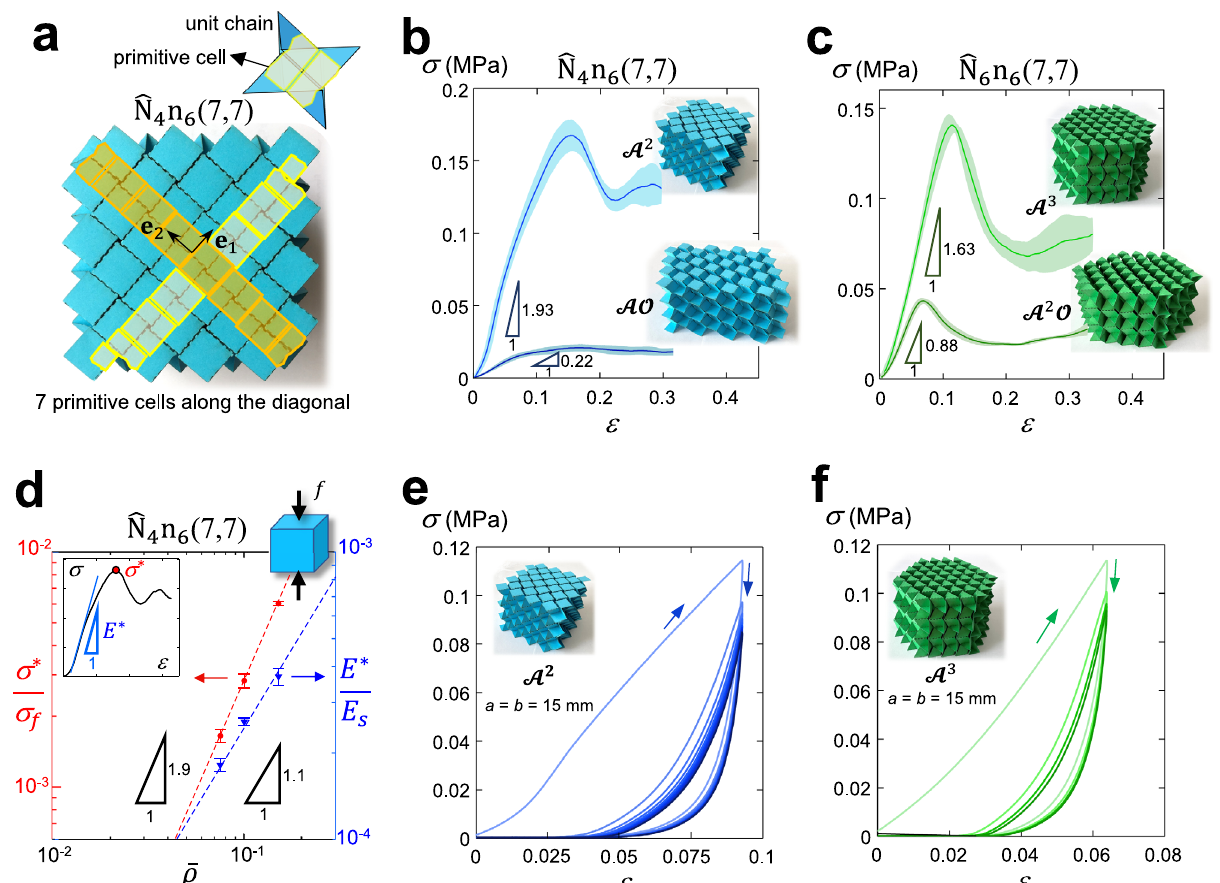
Fig. 5 Out-of-plane compression response of cellular origami-inspired metamaterials. Fabricated samples and measured properties of ^ N 4 n 6 ð 7 ; 7 Þ and ^ N ð 7 ; 7 Þ unit in dissimilar lock modes; a Top view illustration of ^ N 6 n 6 tessellation levels. Engineering stress-strain curves measured for b ^ N 4 n 6 ð 7 ; 7 Þ in two lock con fi gurations A 2 and AO , and for c ^ N 6 n 6 ð 7 ; 7 Þ in two lock con fi gurations A 3 and A 2 O . In b and c the shaded domain describes the dispersion of the results obtained from testing three samples. d Normalized compressive Young ’ s modulus (triangle symbols) and normalized yield strength (circle symbols) of ^ N standard deviation of our measurements. The subset in d schematically illustrates how the compressive Young ’ s modulus E * and yield strength σ * were measured. Cyclic (compressive loading-unloading) response of e ^ N lock modes A 2 and A 3 , respectively, showing the cyclic response stabilizes nearly after four cycles. In these experiments, the unloading is performed at 75% of the compressive strength of the initial cycle of each